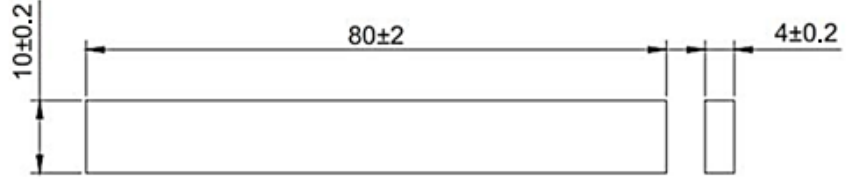
Figure 5. Impact test specimen size.